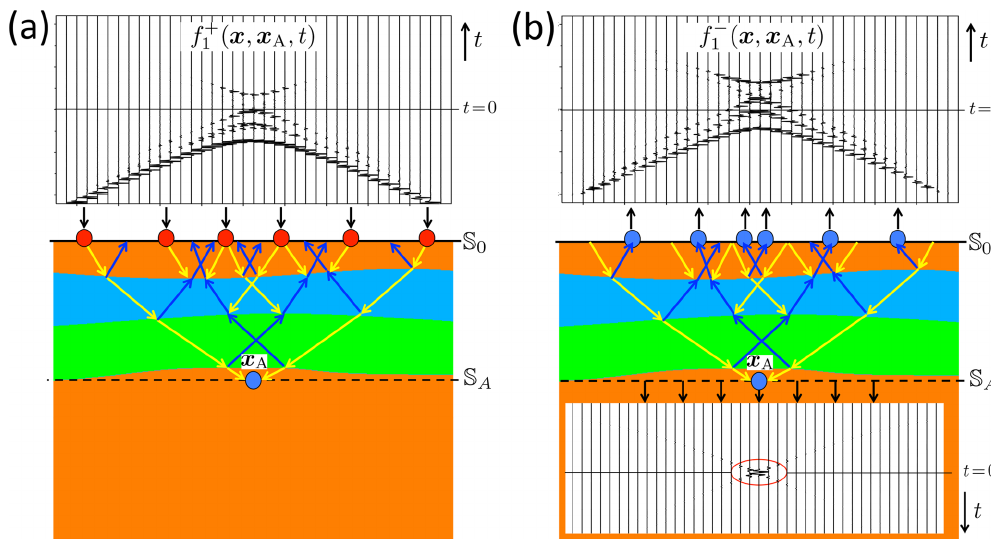
Figure 9. Numerical example of the focusing function. (a) Emission of the downgoing part of the focusing function from S 0 into a truncated version of the actual medium. (b) Responses at S 0 and S A